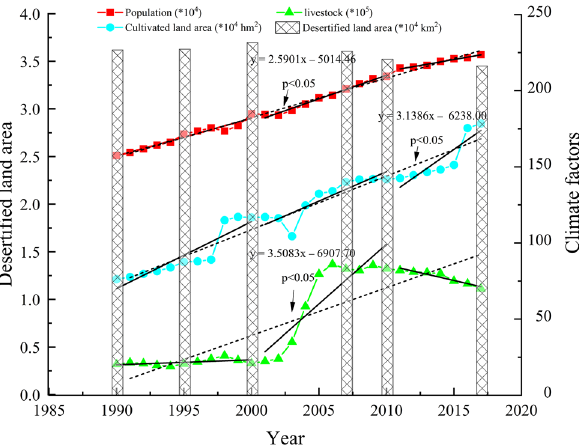
Figure 8. Time series of annual population, livestock production, cultivated land area, and desertified land area of the Mu Us Sandy Land from 1990 to 2017.